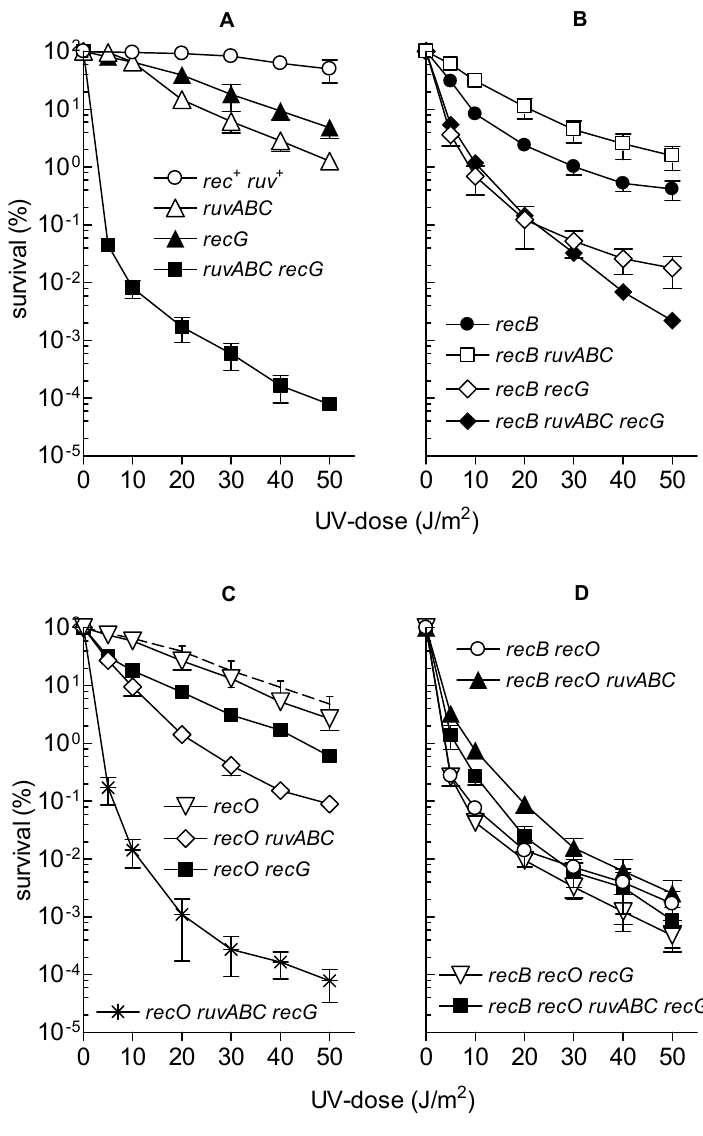
Figure 10. Survival of different E. coli mutants after UV-irradiation. The data for each strain are averages of results from at least three independent experiments, with error bars representing standard deviations. The strains used are listed in the legend to Figure 5. Dashed line on panel ( C ) represents survival of the recG mutant. Statistical analysis is provided in Tables S9 and S10.